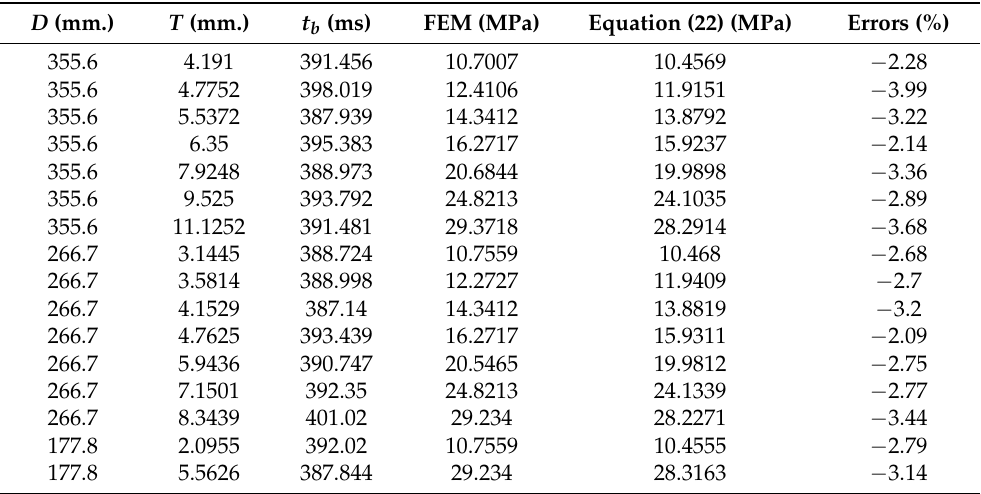
Table A3. Comparisons between the FEM results and the predictions, when t d = 390 ms.